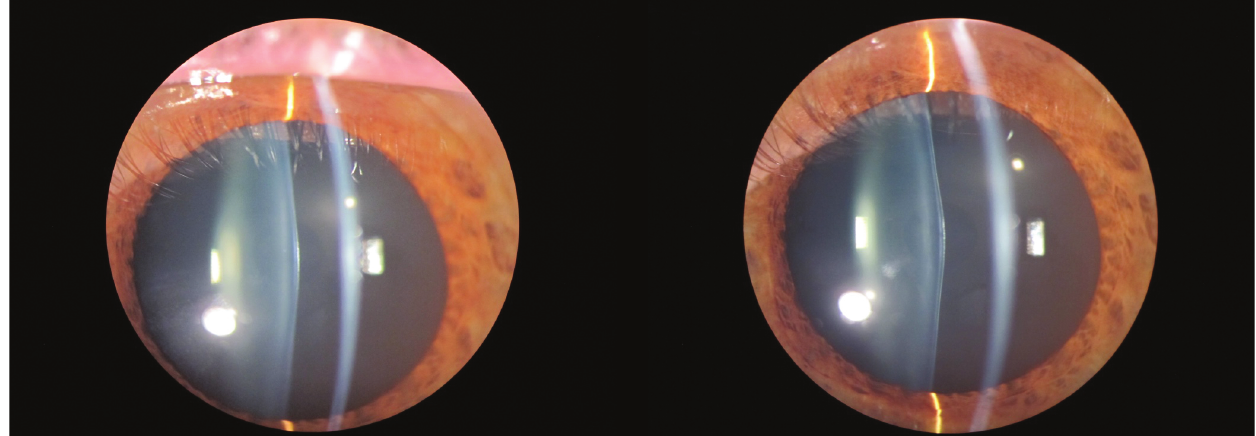
Figure 1. Slit-lamp view of the anterior lenticonus in the right and left eyes of the patient.